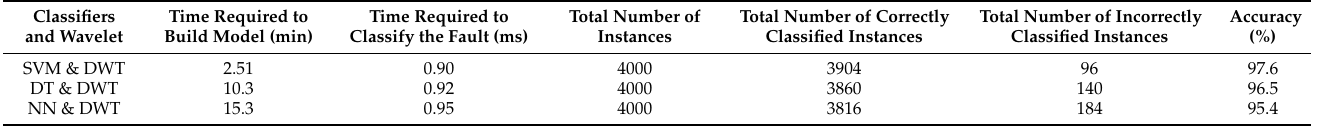
Table 13. Classification accuracy of different classifiers using simulation data with